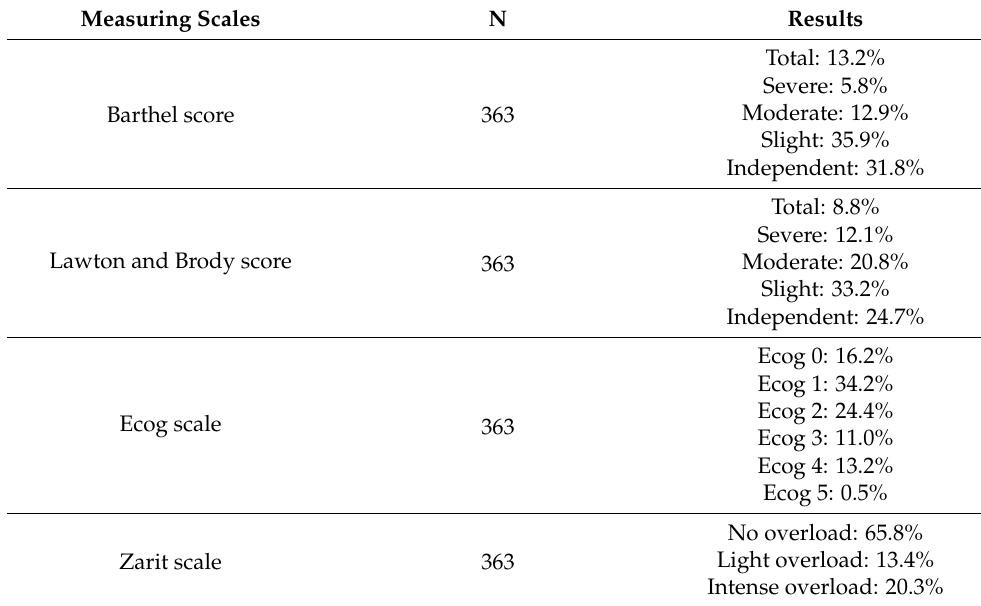
Table 2. Scores on the IB, Lawton and Brody, ECOG and Zarit scales of the sample. Measuring Scales N Results